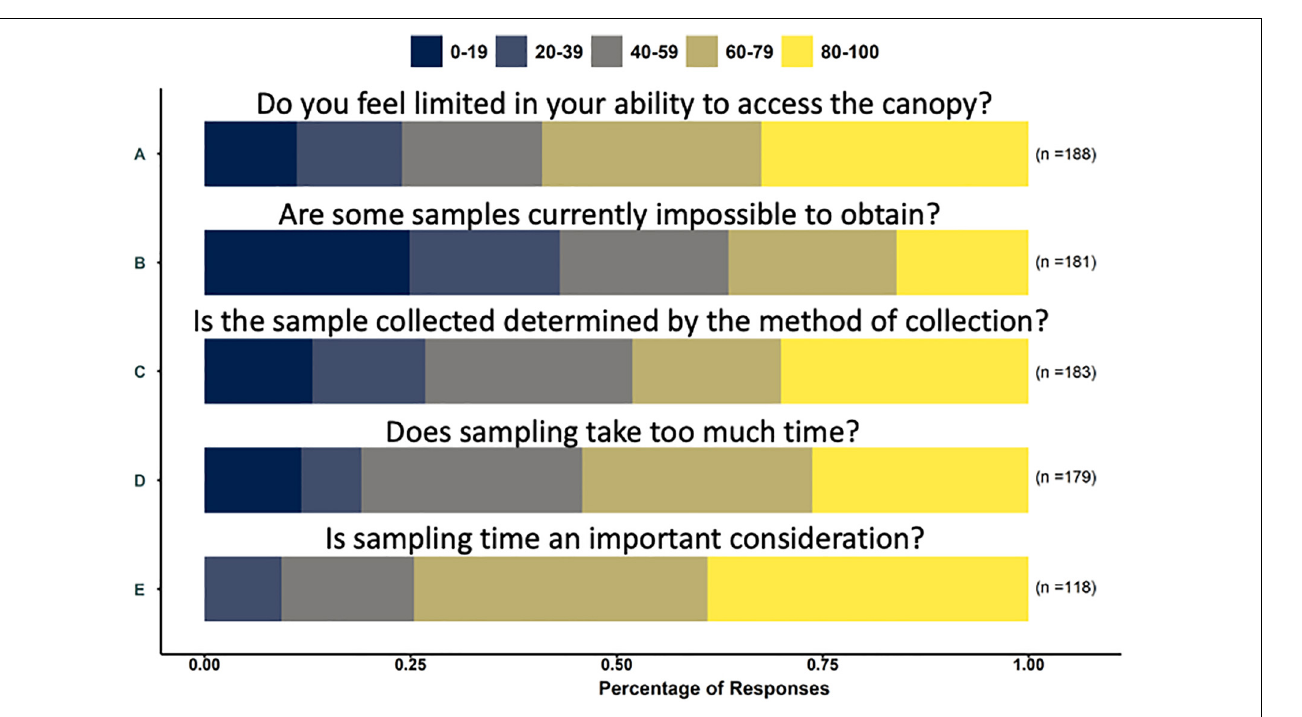
FIGURE 5 | Responses to questions about current ability to access tree canopies from respondents in an online survey about conducting research and management in the arboreal ecosystem. Questions were: (A) Do you feel limited in your ability to access the canopy? (B) Are some samples currently impossible to obtain? (C) Is the sample collected determined by the method of collection? (D) Does sampling take too much time? (E) Is sampling time an important consideration? Respondents expressed their agreement with the question by choosing a number between zero and 100, with 100 being total